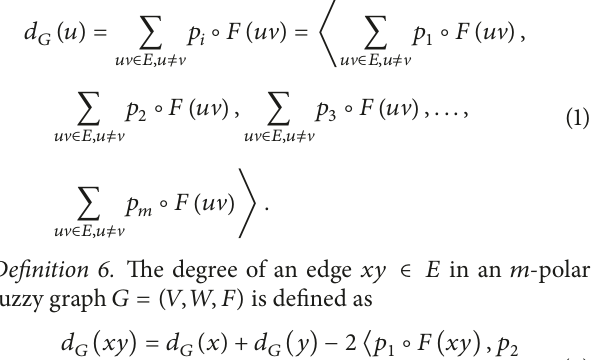
Figure 1: 3-polar fuzzy graph 𝐺